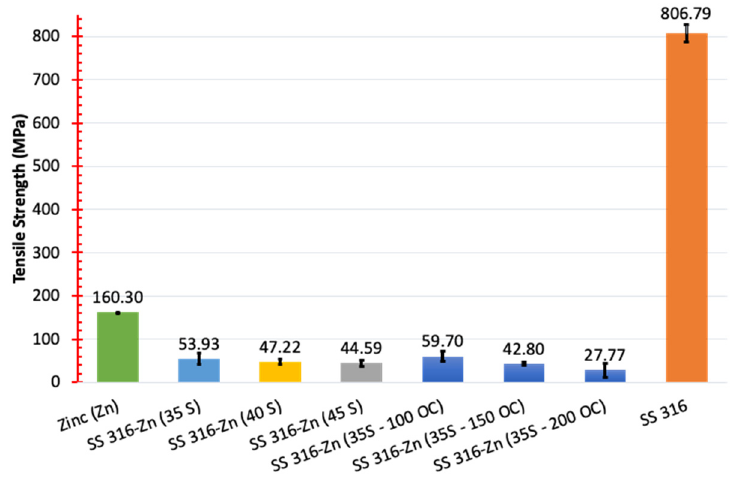
Figure 5. Tensile strength of SS 316-pure Zn joints rotary friction-welding (friction time of 35 s, 40 s, 45 s, 35 s—100 ◦ C, 35 s—150 ◦ C, and 35 s—200 ◦ C, rotation speed at 1450 rpm, friction pressure at 3.9 MPa, and forging pressure at 6.9 MPa) with base